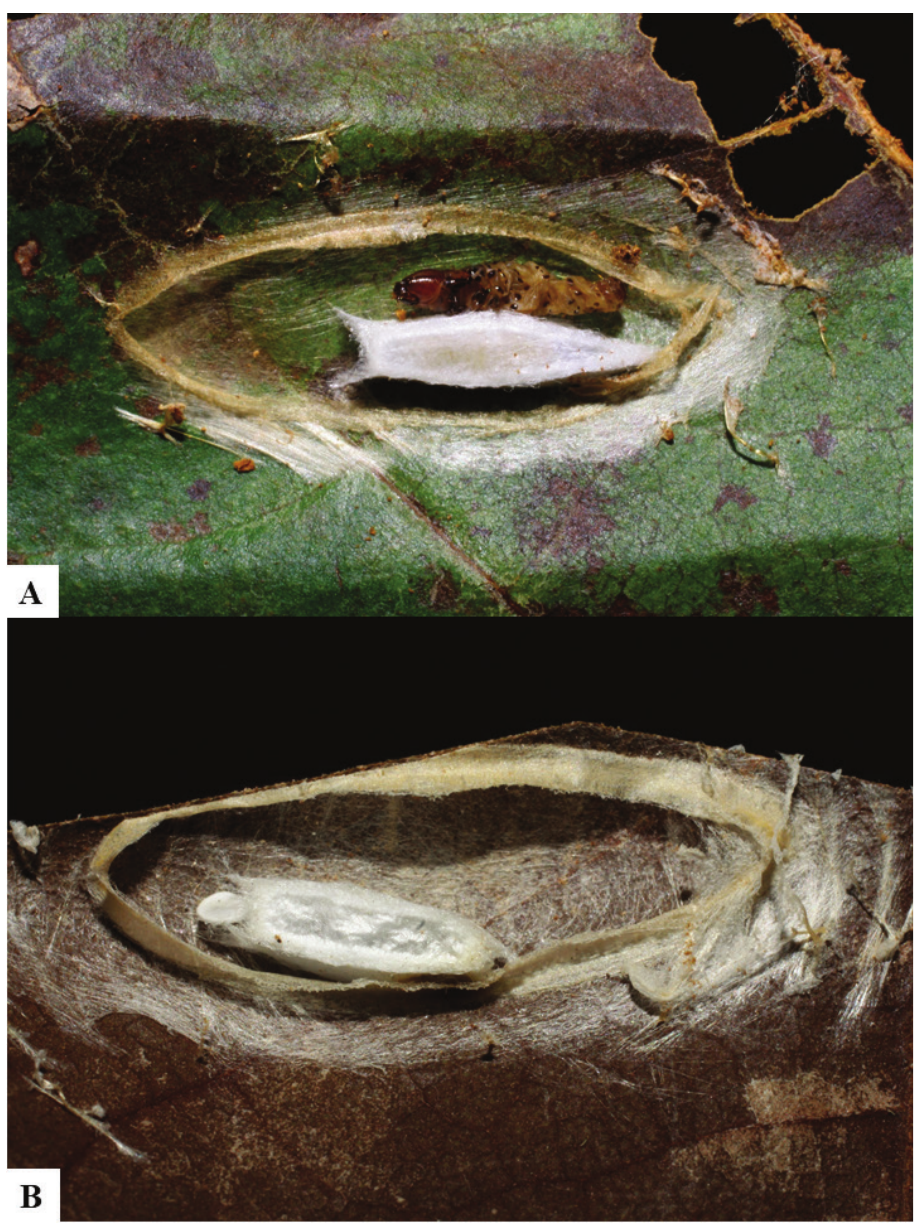
Figure 15. A, B Cocoons of Dolichogenidea melaniamunozae sp.